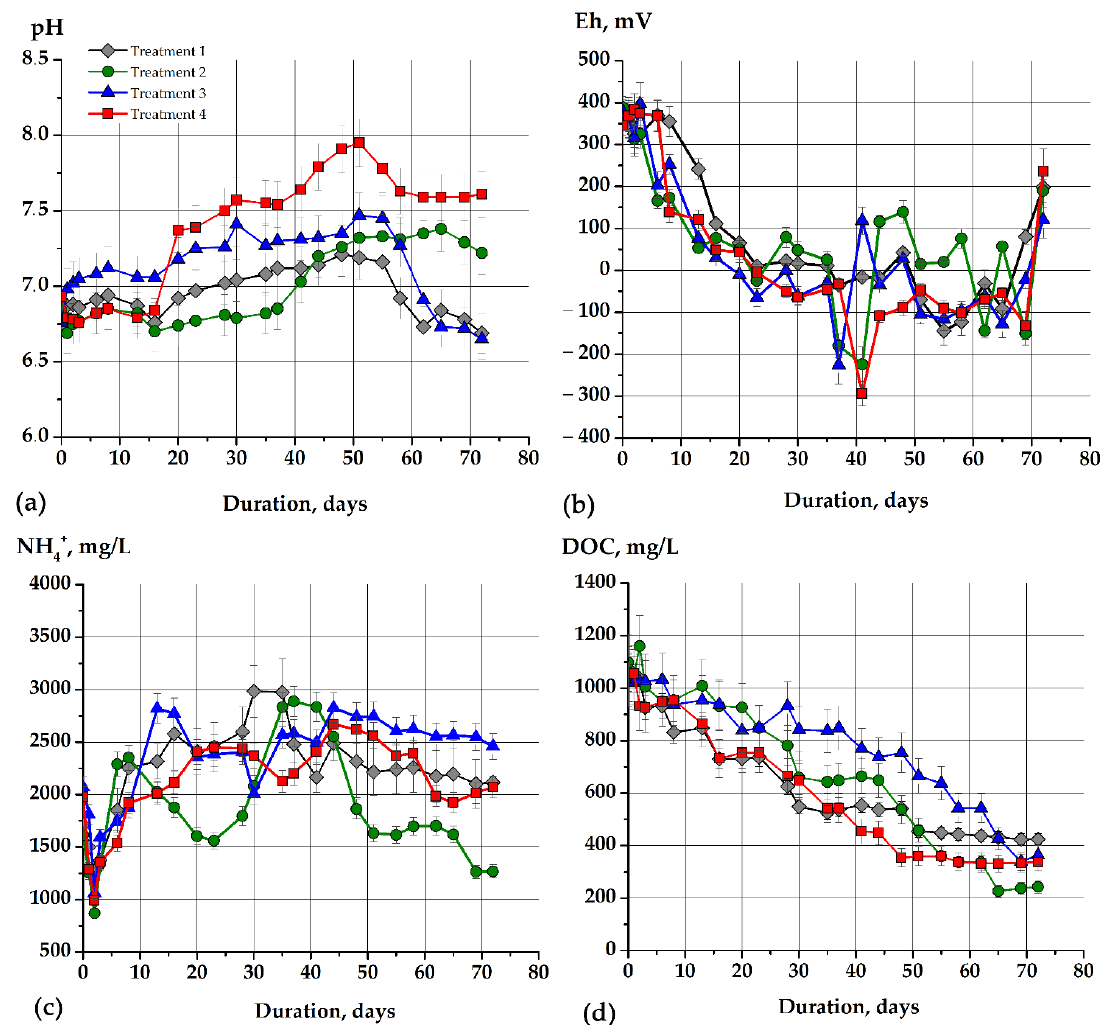
Figure 2. The basic metabolic parameters of the sodium acetate and model soapstock fermentation process: ( a ) pH, ( b ) (Eh), ( c ) (DOC), ( d ) NH 4+ . The figure shows the dynamics of changes in metabolic parameters in different cases with sodium acetate and non-adapted methanogens (gray lines, treatment 1), sodium acetate with adapted methanogens (green lines, treatment 2), model soapstock as a substrate and non-adapted methanogens (blue lines, treatment 3), model soapstock as a substrate and adapted methanogens (red lines, treatment 4).